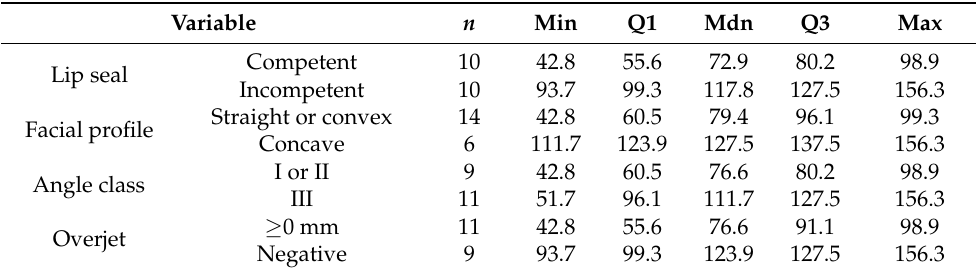
Table 4. Electrical activity of the upper lip [ µ V/ µ V%] during saliva swallowing in the cleft group